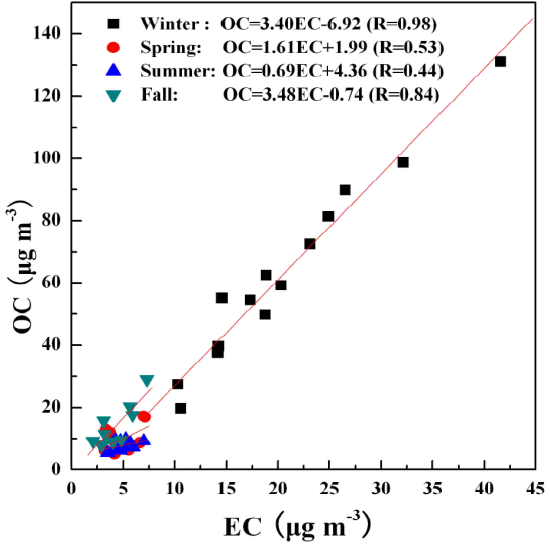
Figure 3. Seasonal correlations between OC and EC in